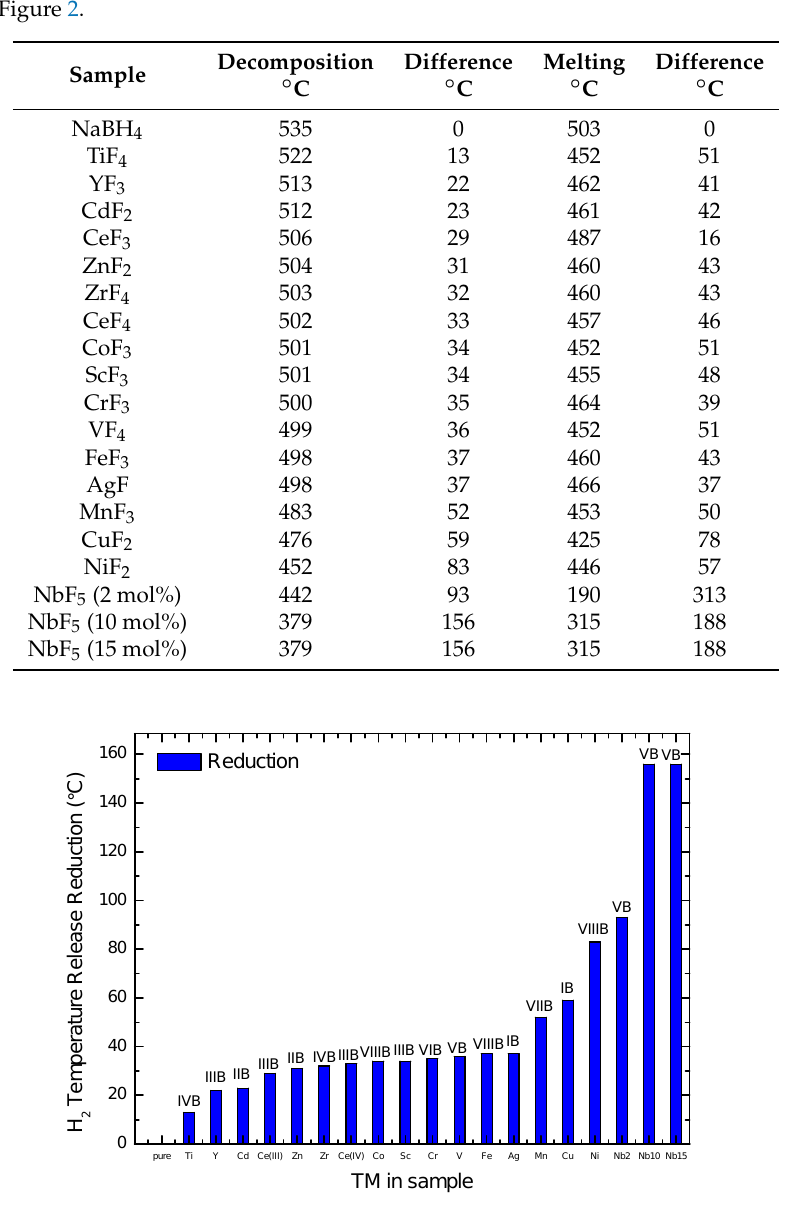
Figure 2. Temperature difference between the main decomposition peak of the samples with additives and that of pure NaBH 4 as observed by